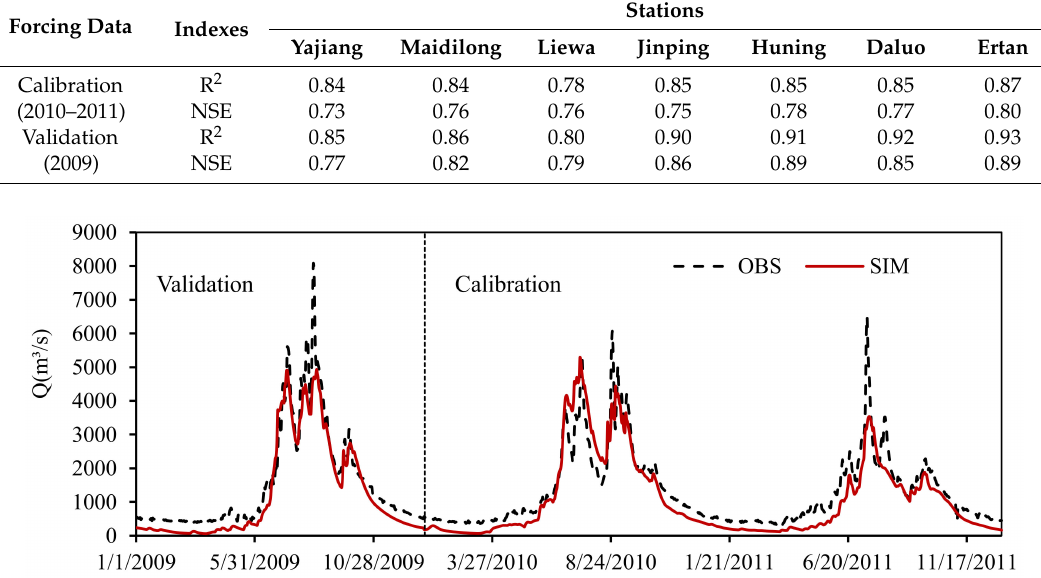
Figure 2. The daily simulation results for runoff (2009–2011) at Ertan control station. (OBS represents the observation data, and SIM represents the simulation